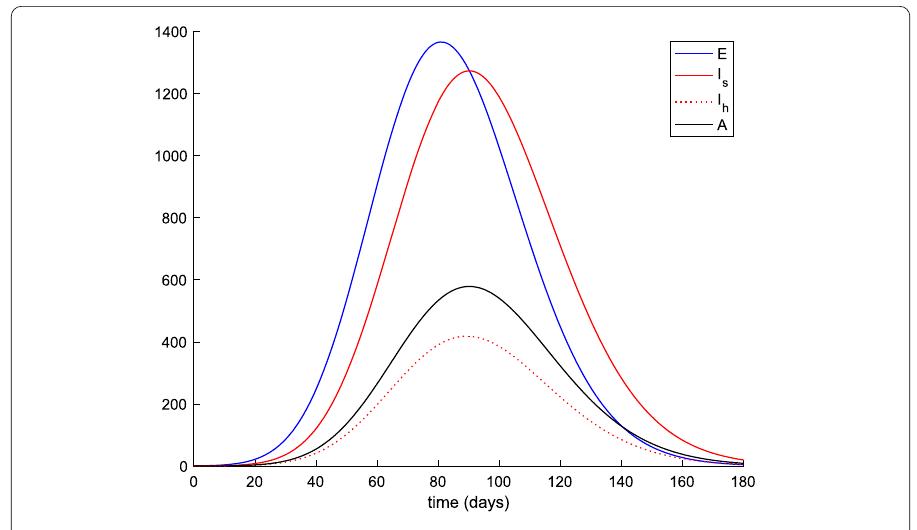
Figure 7 Evolution of exposed and infectious (slight, hospitalized, and asymptomatic) when vaccination is applied and no treatment is used. The vaccination gain is set to k V = 0.001